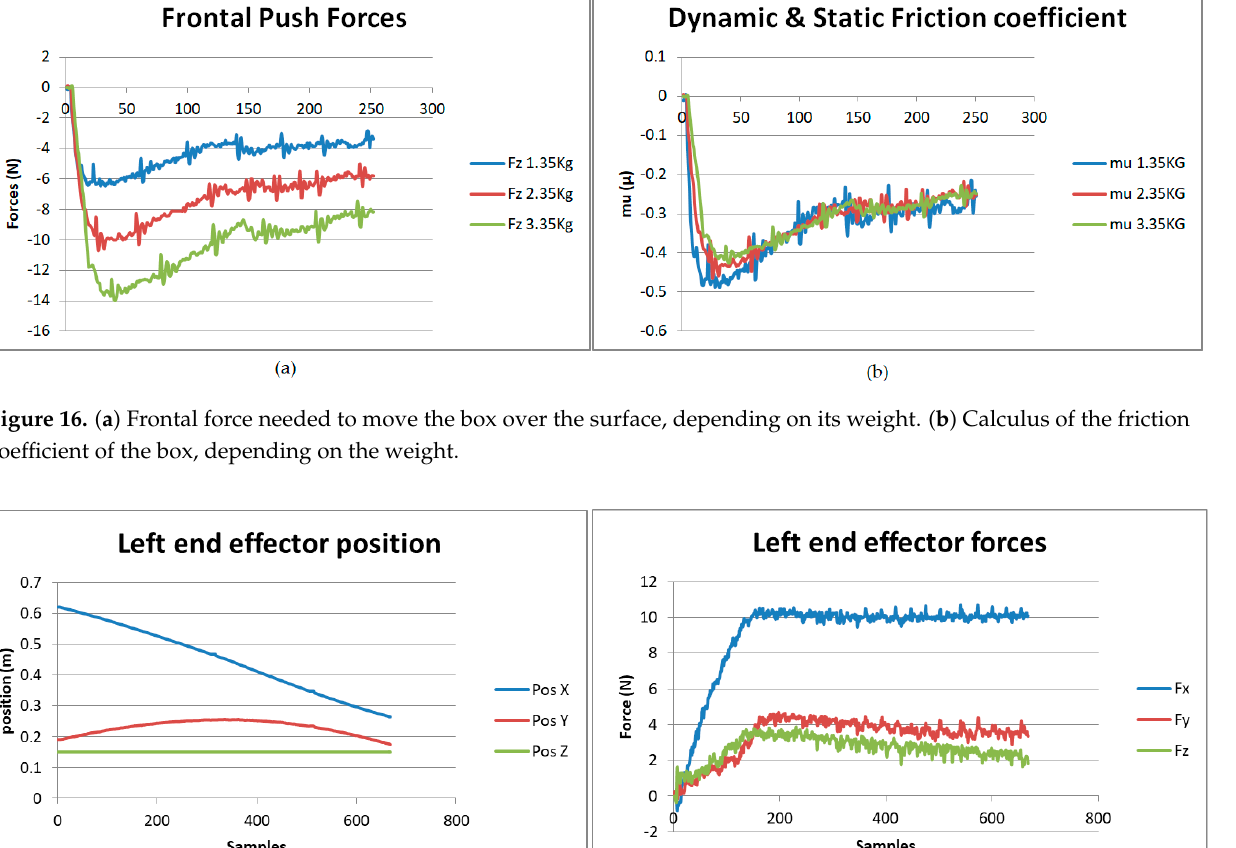
Figure 17. ( a ) Position of the left end effector while spinning the box. ( b ) Forces detected in the spinning movement.